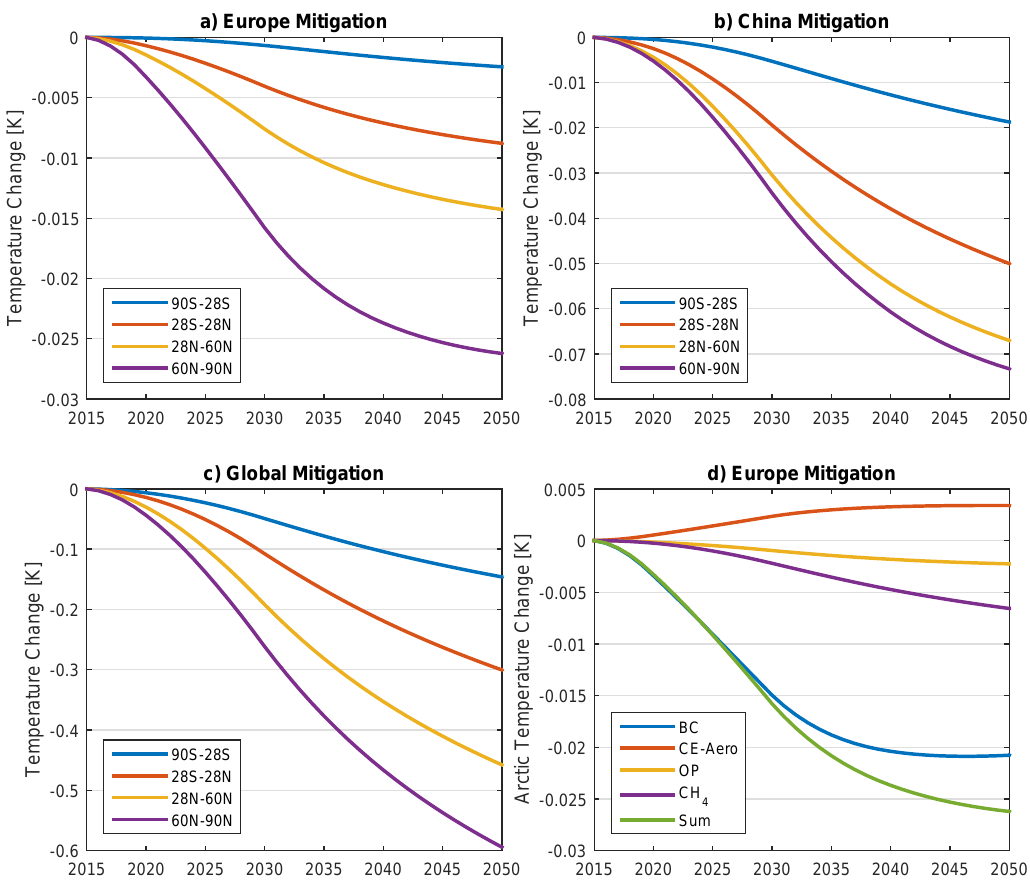
Figure 21. Annual mean surface temperature changes estimated by the ARTP method. Panels (a–c) : changes in four latitude bands due to ECLIPSE mitigation scenario (MIT–CLE) for mitigation in Europe (a) , China (b) and globally (c) . Panel (d) : Arctic temperature changes due to mitigation of individual components from Europe. CE-Aero: co-emitted aerosol (precursor) species (OA, SO 2 and NH 3 ) , OP: Ozone precursors (NO x , CO and NMVOCs). Note the different scales on the vertical